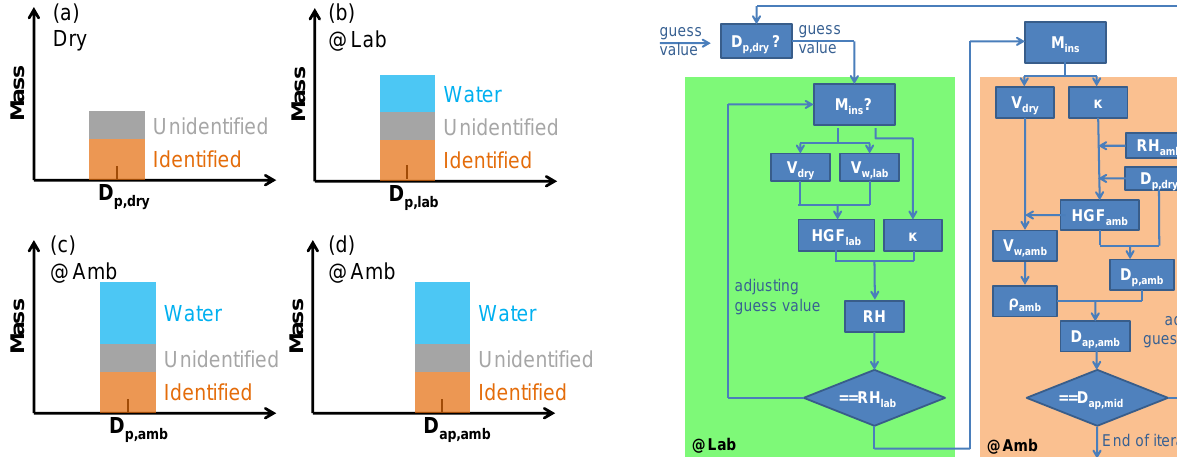
Fig. 2. Schematic representation of the iterative algorithm for evalu- ating κ values of particles: the laboratory-related variables and cal- culations are displayed on the green background, and the ambient- related variables and calculations are displayed on the brown back-